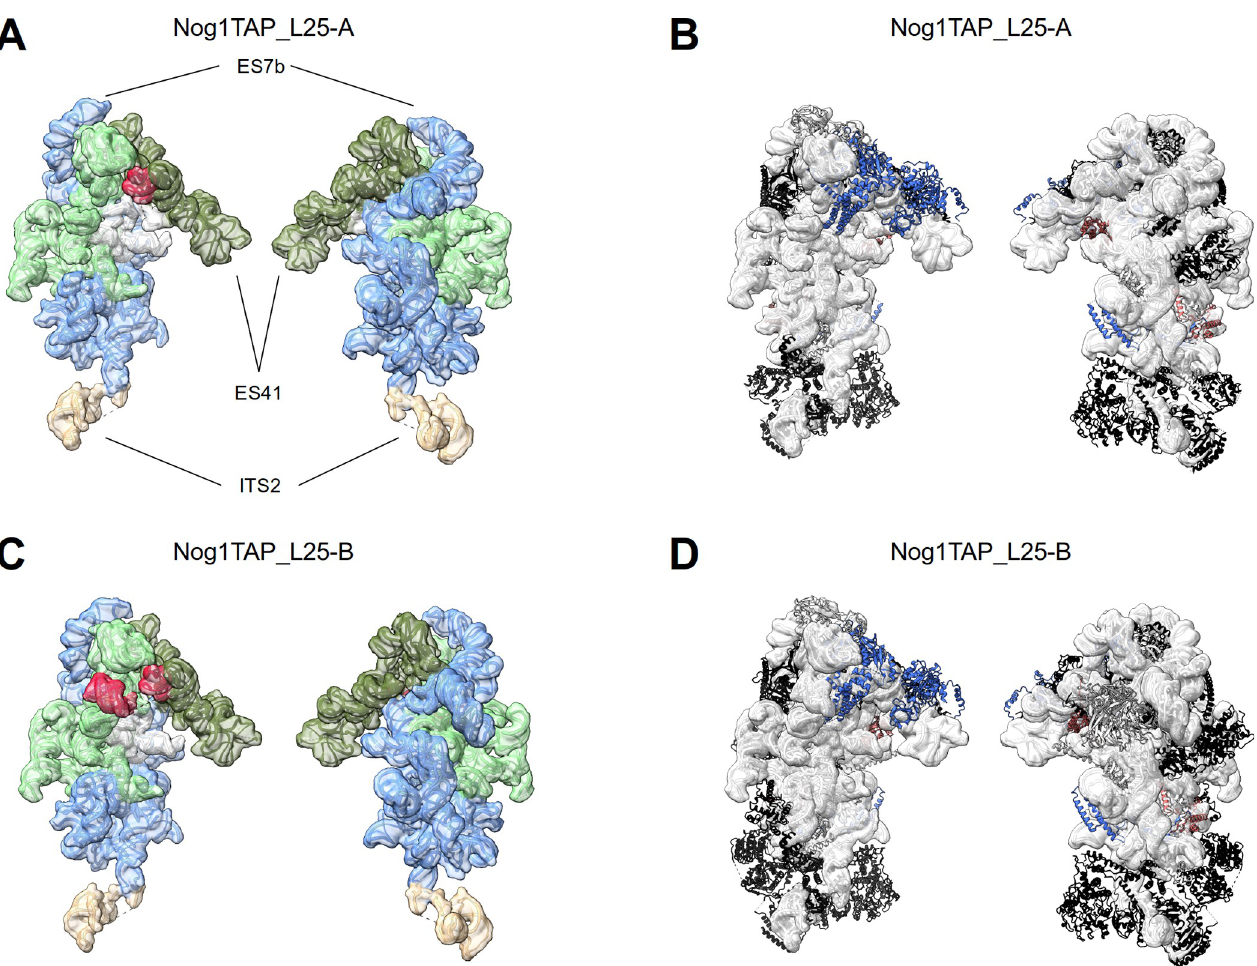
Fig 5. rRNA folding states and structure models of Nog1-TAP associated particle populations from yeast cells in vivo depleted of rpL25 (Y1816). Folding states of rRNA domains and a structure overview are shown for Nog1TAP_L25-A in (A) and (B) and for Nog1TAP_L25-B in (C) and (D). Structure model visualisation and protein colouring for (B) and (D) is described in the legend of Fig 2 and rRNA domain visualisation and colouring for (A) and (C) in the legend of Fig 3. In (A)—(D) the LSU subunit interface side is shown on the left and the subunit solvent surface side on the right. The individual LSU rRNA helices as well as the protein composition and model-based interaction networks detected in structure models Nog1TAP_L25-A and Nog1TAP_L25-B are schematically represented in figures K and L in S1 Appendix.